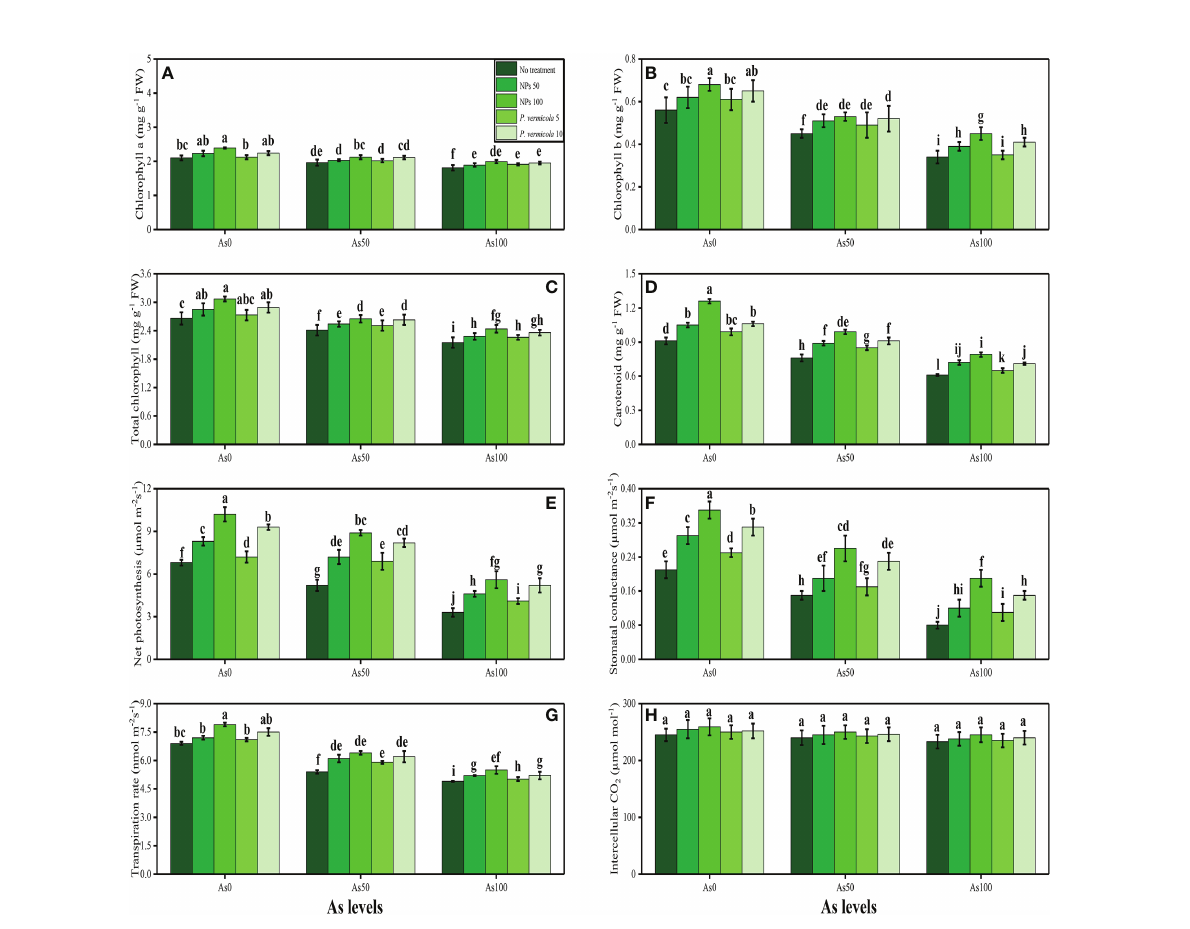
FIGURE 2 Effect of combined application of various levels of iron oxide nanoparticles (FeO-NPs) (i.e., 50 mg/l − 1 and 100 mg/l − 1 ) and plant growth- promoting bacteria ( Providencia vermicola ) (i.e., 5 ppm and 10 ppm) on chlorophyll-a content (A) , chlorophyll-b content (B) , total chlorophyll content (C) , carotenoid content (D) , net photosynthesis, (E) stomatal conductance (F) , transpiration rate (G) , and intercellular CO 2 (H) of Ajwain ( Trachyspermum ammi seedlings) grown under various stress levels of arsenic (i.e., 0 m M, 50 m M, and 100 m M). Values are demonstrated as means of four replicates along with standard deviation (SD; n = 4). Two-way ANOVA was performed and means differences were tested by Tukey ’ s highly signi fi cant difference post-hoc test ( p < 0.05). Different lowercase letters on the error bars indicate signi fi cant difference between the